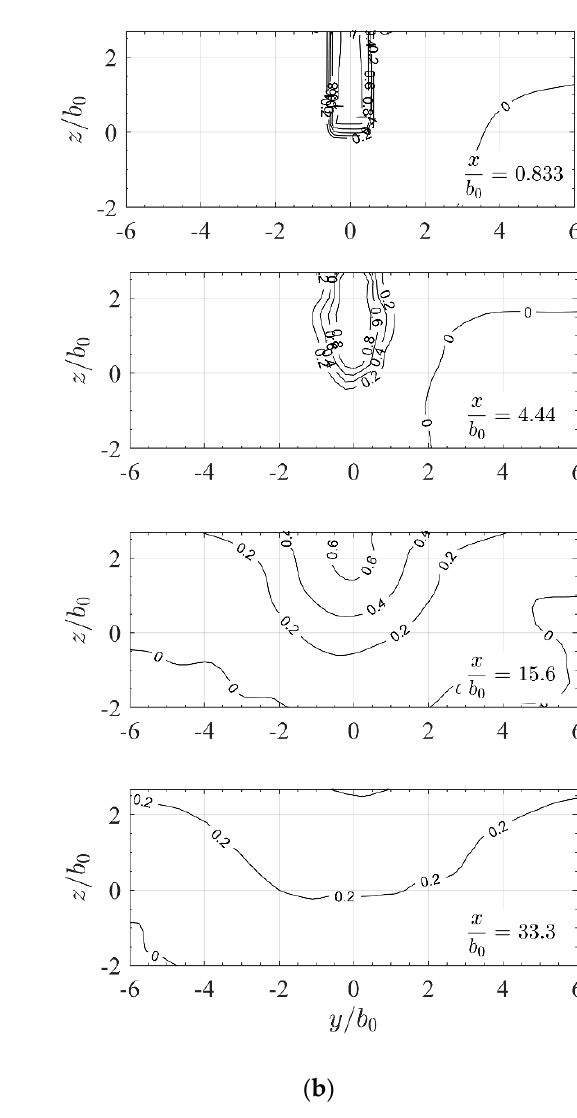
Figure 7. Qualitative comparison of instantaneous distribution of the tracer concentration of ( a ) ch and ( b ) si jet.